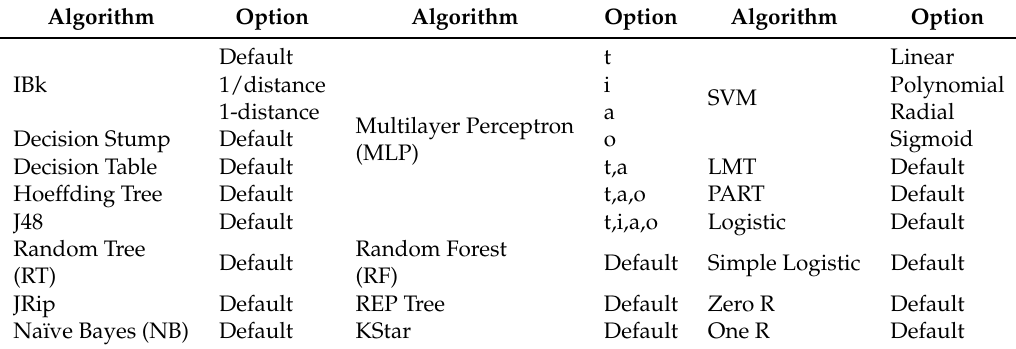
Table 3. List of algorithms used for training